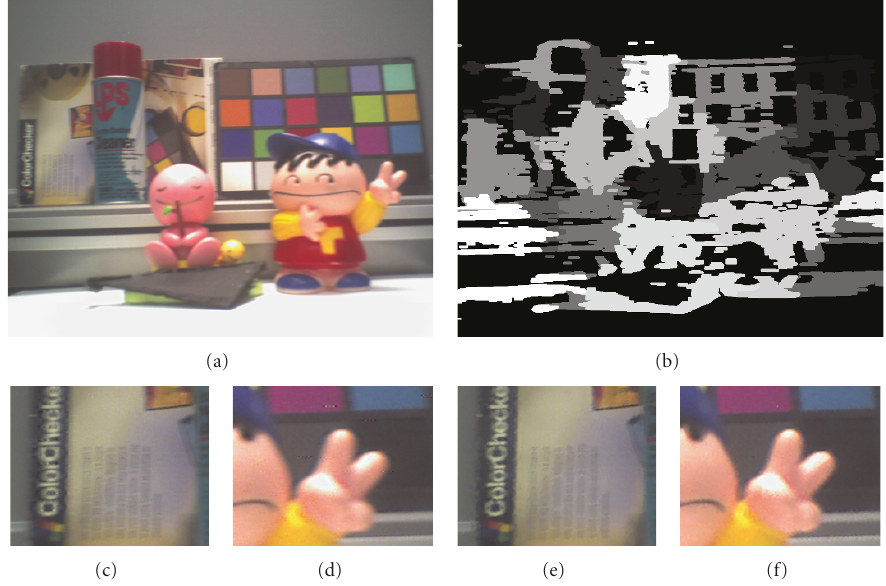
Figure 15: Comparison of restoration results on Miniature image. (a) Blurred image. (b) Segmentation result. (c)-(d) Magnified region of the deblurred image obtained by [7]. (e)-(f) Magnified region of the deblurred image obtained by the proposed algorithm.